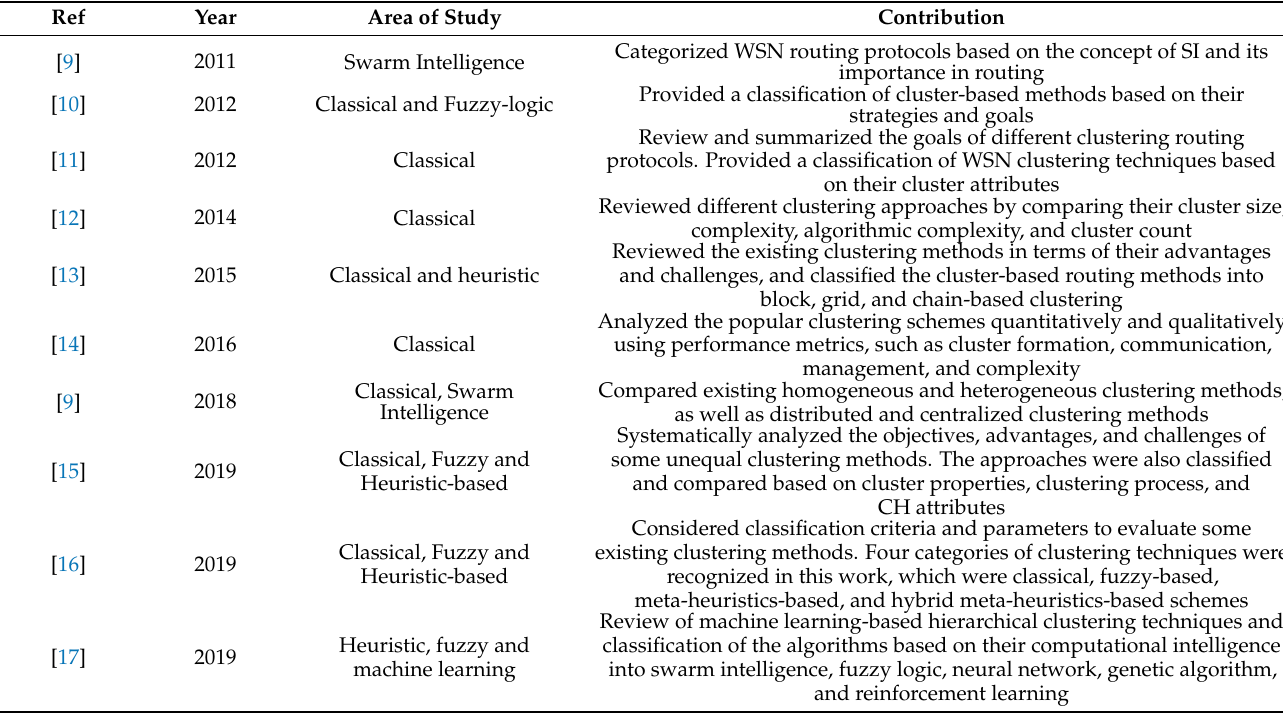
Table 1. Literature reviews of clustering